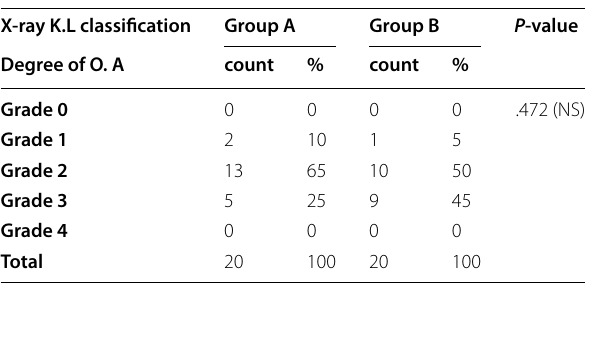
Table 3 X‑ray Kellgren‑Lawrence (KL) classification of knee OA in both groups pre‑operative